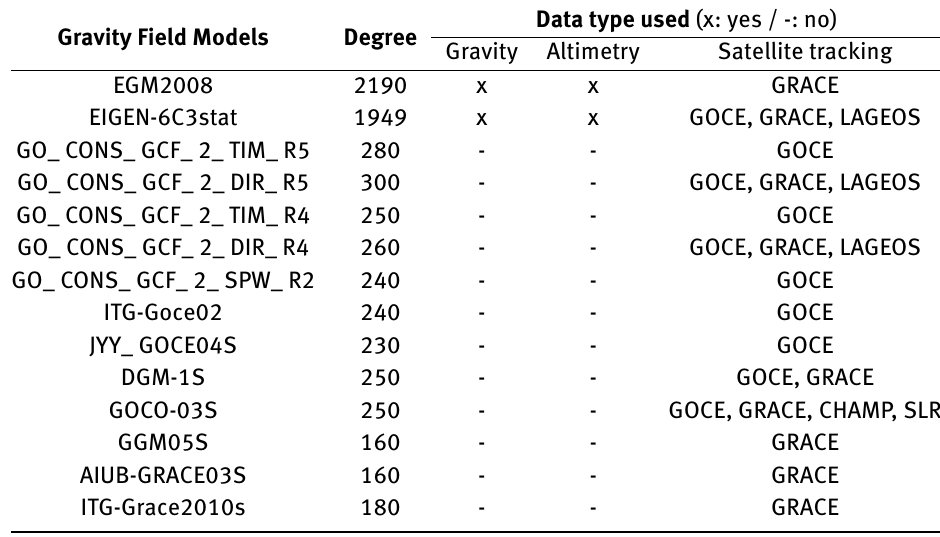
Table 1: Satellite data and maximum degree of the used Earth gravity models.